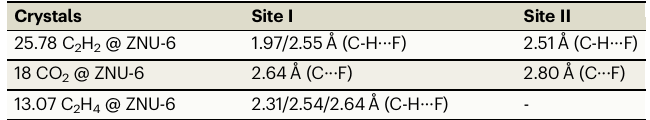
Table 1 | The distances of the host – guest interactions Crystals Site